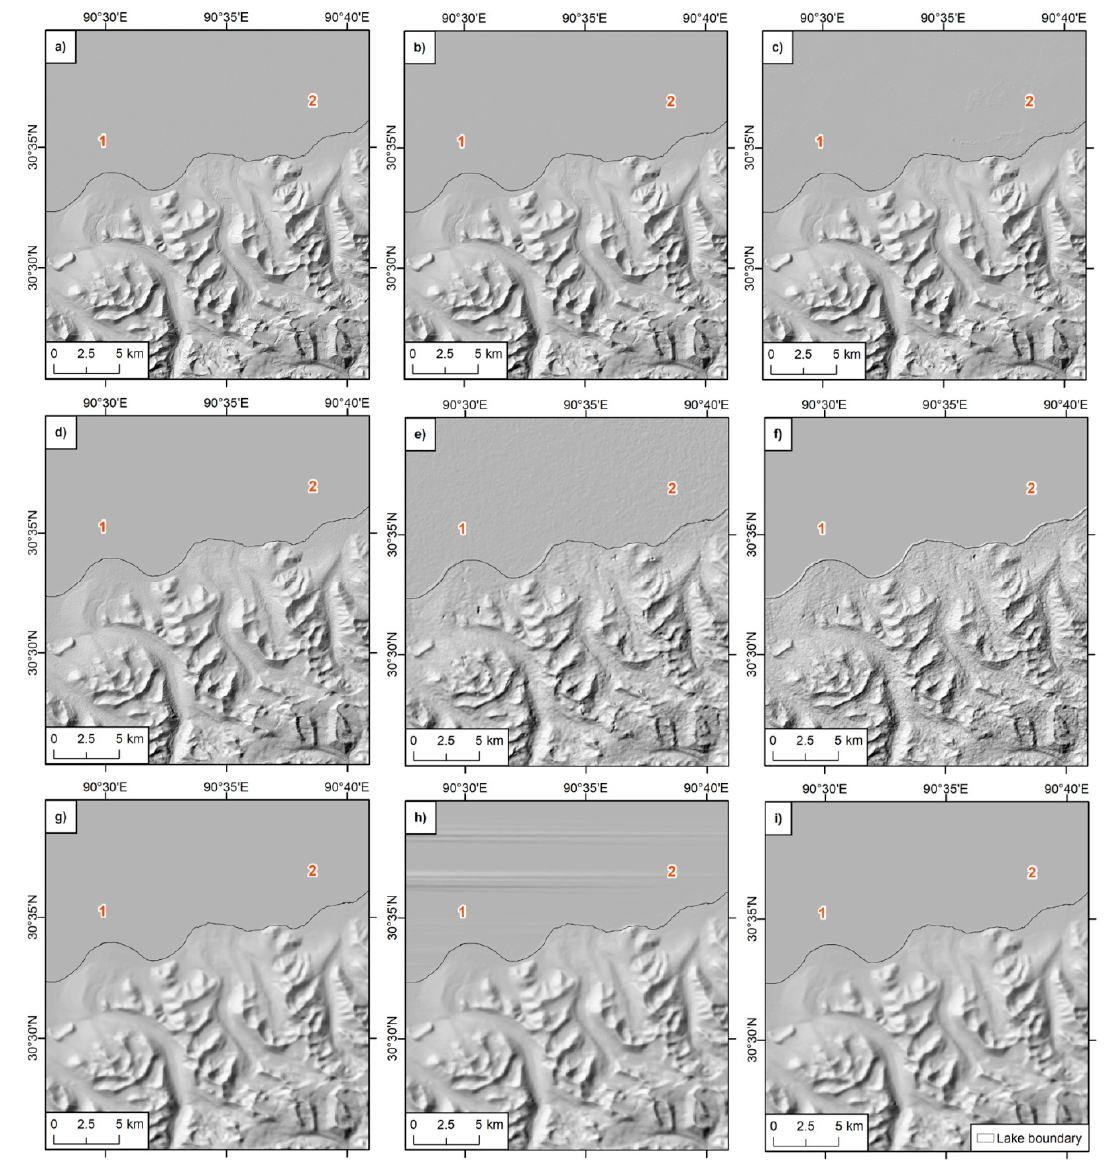
Figure 11. Hillshade DEMs of subcatchments in Figure 9 with lake boundary: ( a ) TanDEM-X 12 m (©DLR 2017), ( b ) TanDEM-X 30 m (©DLR 2017), ( c ) ALOS 30 m (©EORC & JAXA 2017), ( d ) SRTM 30